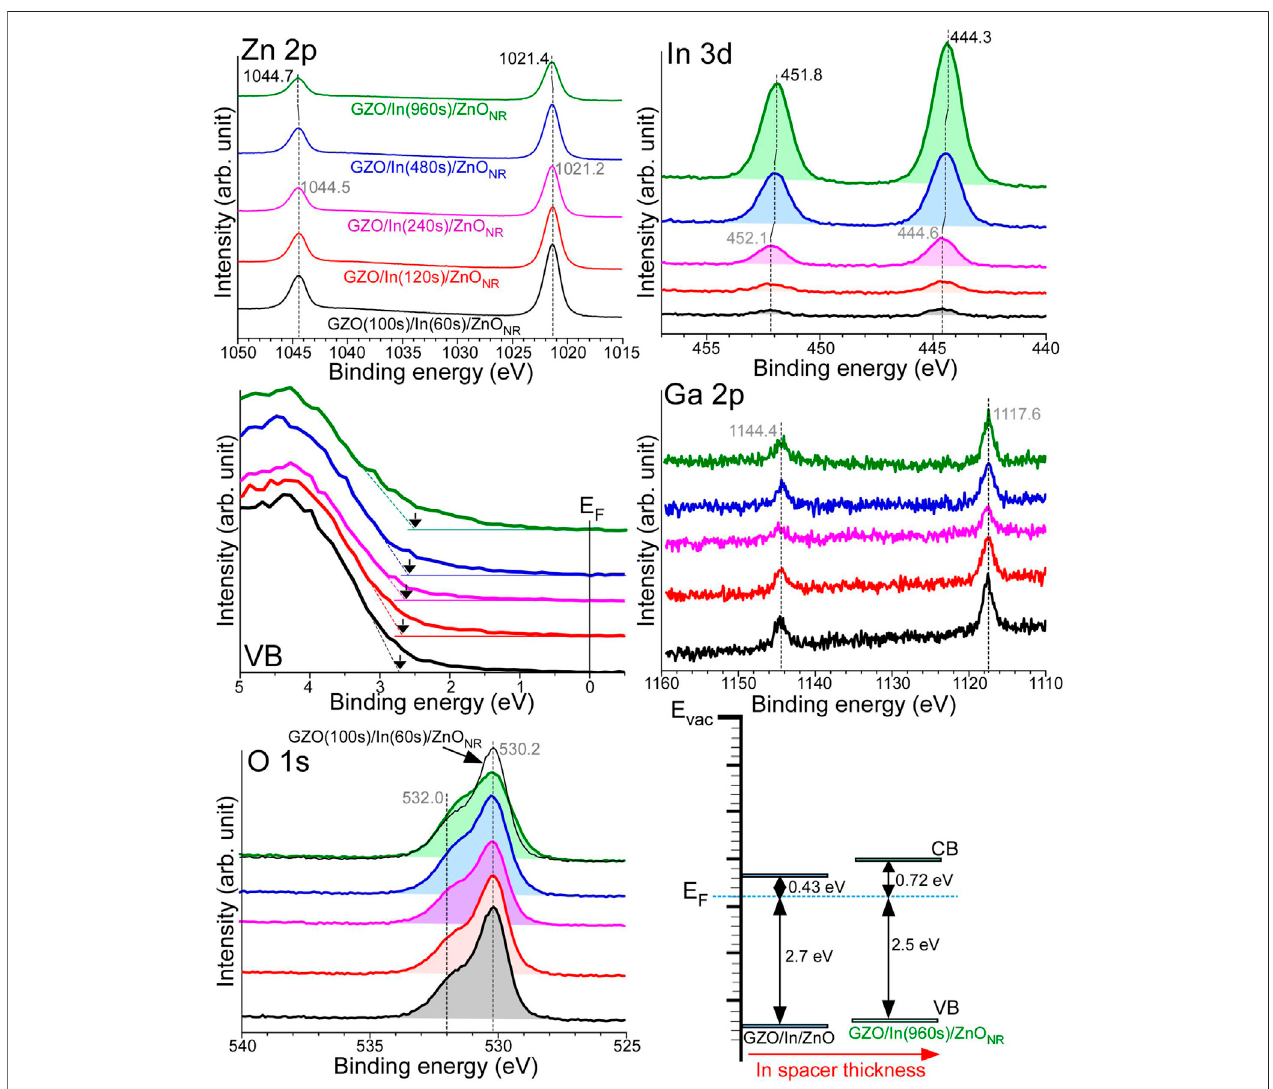
FIGURE7| Zn2p,In3d,VB,Ga2p,andO1sXPSpro fi lesforGZO(100s)/In/ZnO NR withInthicknessesof60,120,240,480,and960 s.Theinterfacialenergylevel alignments for GZO(100s)/In(60s)/ZnO NR and GZO(100s)/In(960s)/ZnO NR samples.